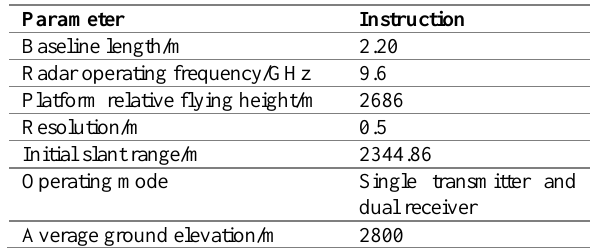
Table 1. The SAR system platform